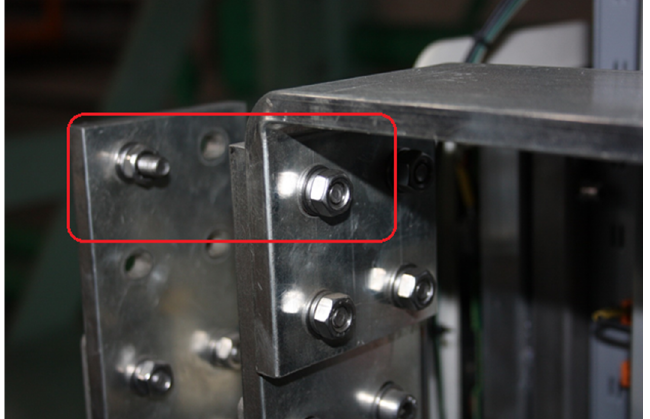
Figure 15. Shortening of metal bolts.